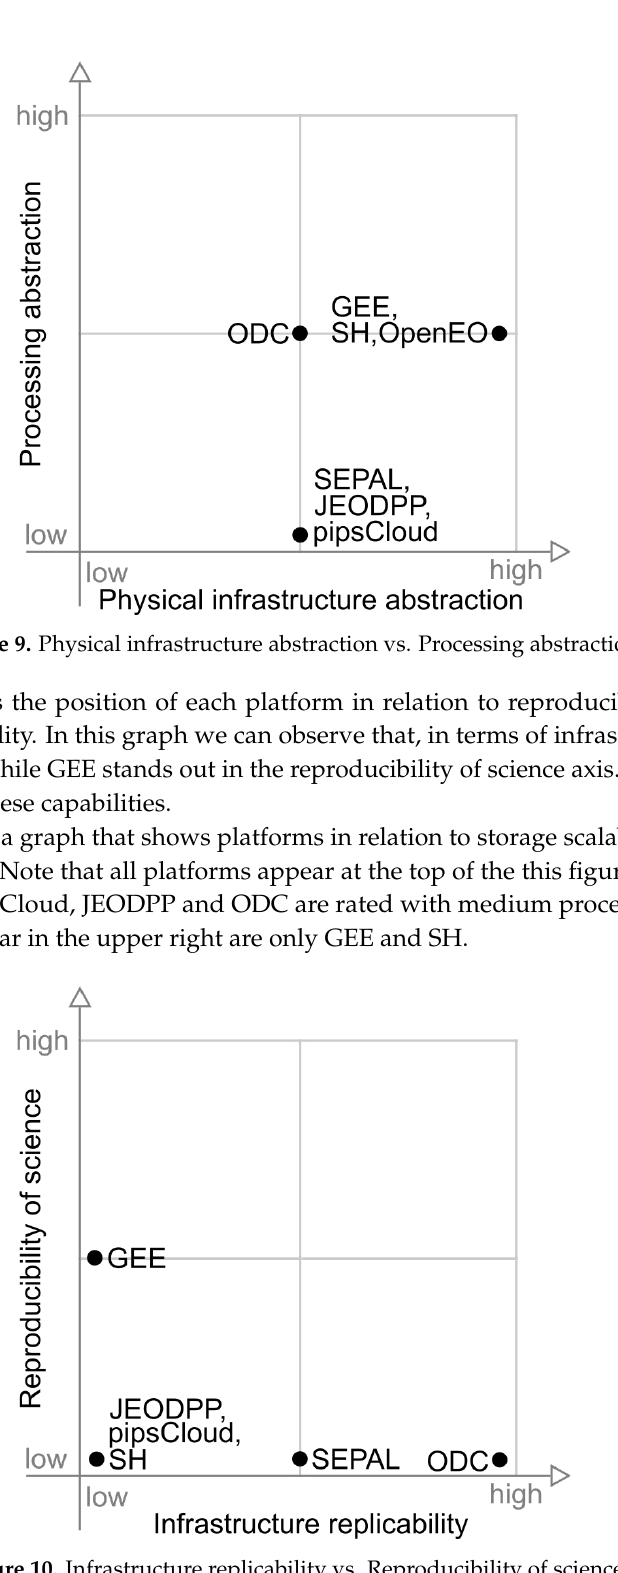
Figure 10. Infrastructure replicability vs. Reproducibility of